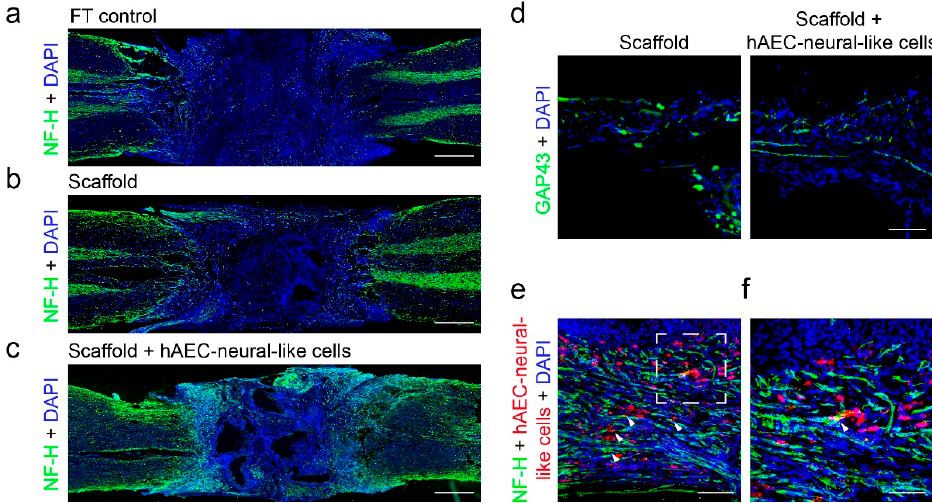
Figure 6. Implantation of hAEC-neural-like cell biomimetic scaffolds in the lesion partially recover the neural circuit in a rat model of full transection spinal cord injury. ( a – c ) The fluorescence images of NF-H (green) axons showing the growth of nerve fibers around the lesion from the indicated groups; ( d ) the growth and projection of axons in micro-channels between empty scaffold and hAEC-neural-like cell biomimetic scaffold groups at 8 weeks post implant; ( e , f ) the fluorescence images indicated that some of the NF-H-marked axons co-localized with hAEC-neural-like cells (pre-labeled with red fluorescence) in channels (white arrow heads), f is the magnified image of the white dotted frame in e. Scale bars: ( a – c ): 1 mm; ( d ): 100 μ m; ( e ): 120 μ m; ( f ): 60 μ m.